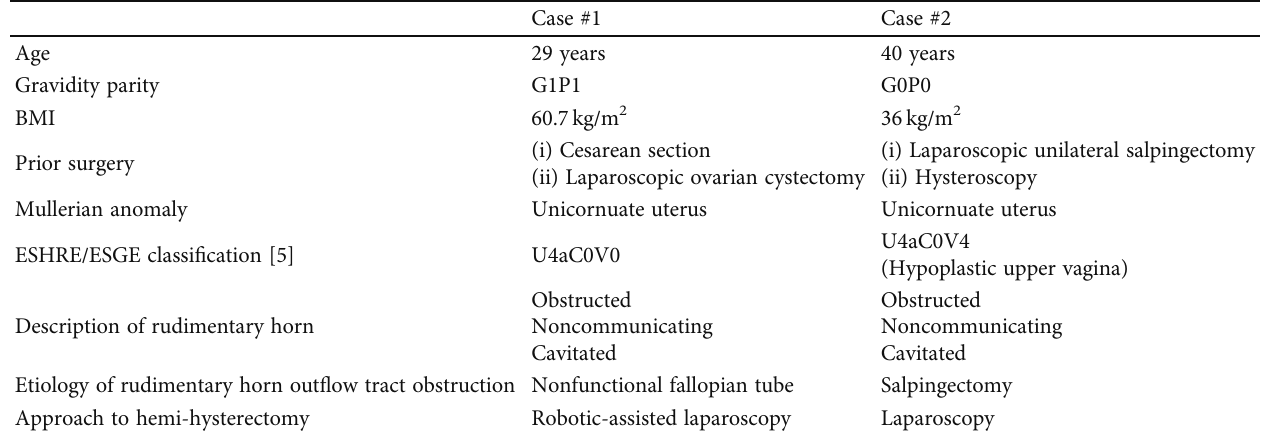
Figure 5: (a) Intraoperative view of distended noncommunicating left horn. (b) Shallow myometrial defect after removal of left horn. Table 1: Patient